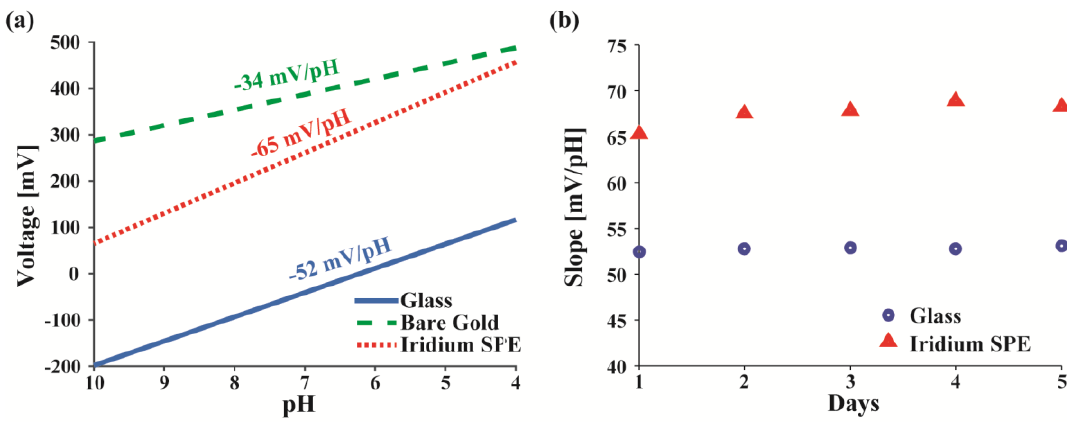
Figure 6. ( a ) Calibration curve of glass, bare gold SPE, and Iridium-Oxide electrode; ( b ) pH slope drift over several days for different electrode types. over several days for different electrode